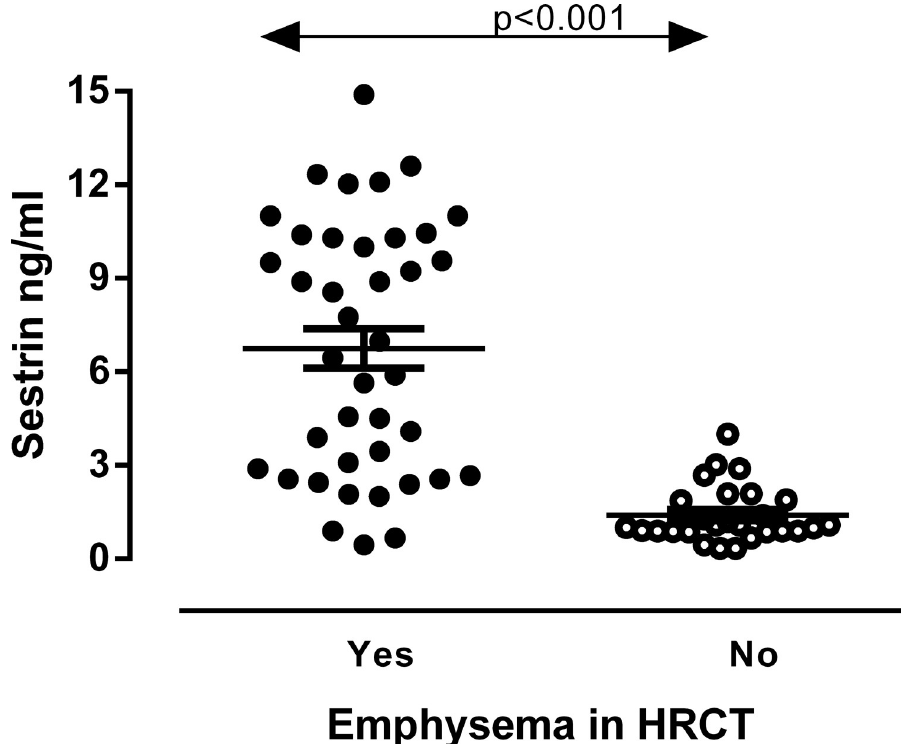
Fig 1. Serum Sesn2 levels according to the presence of emphysema in HRCT. For data see text. Abbreviations: HRCT: High Resolution Computed Tomography.